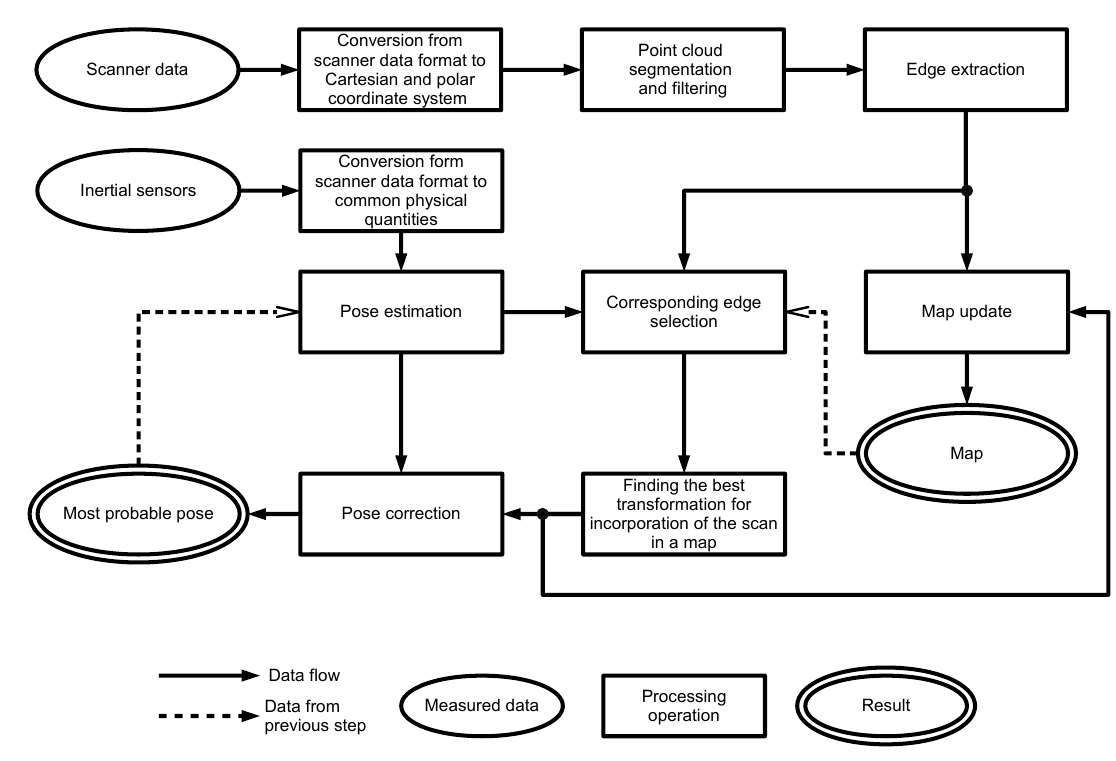
Figure 1. Overall scheme of point cloud processing system from data acquisition to map and pose